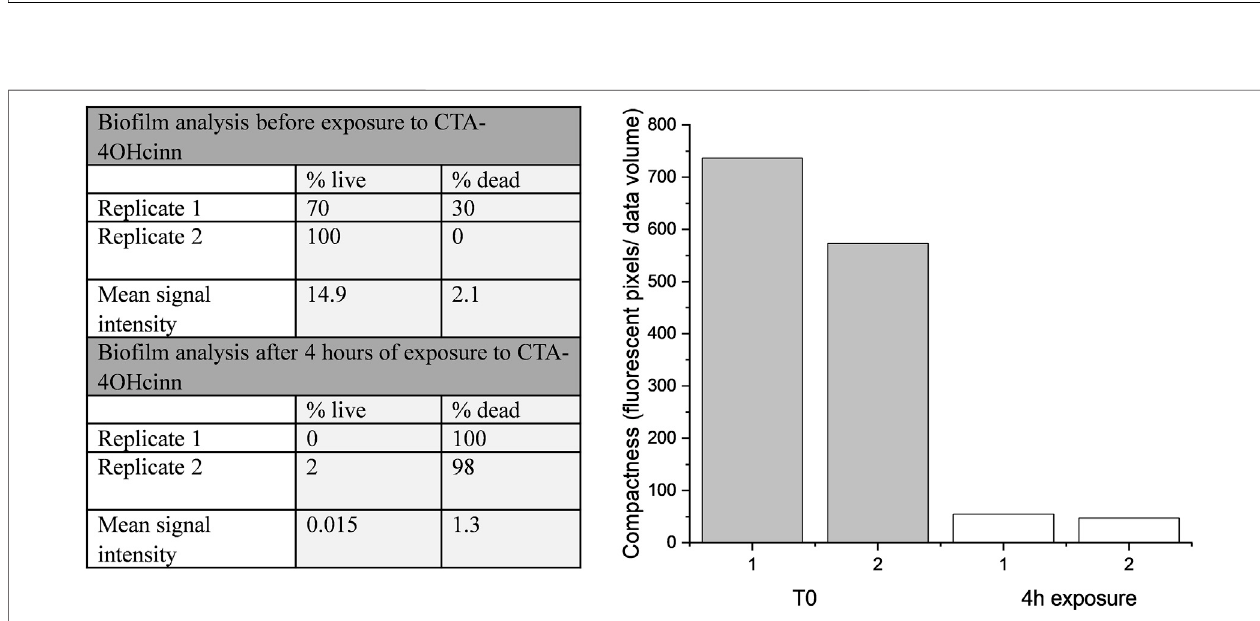
FIGURE 3 | IMARIS (Bitplane) analysis of replicate Nyquist CLSM micrographs as % live cells and % dead cells, and mean signal intensity from green and red channels(left).Fluorescentpixels(pixelsthatreturnedagreenorredsignal)dividedbythetotalvolumeofdataprovidesanestimationofbio fi lmcompactness(right).This data was constructed from micrograph compactness values before (T 0 ) and after 4 h of exposure to CTA-4OHcinn.